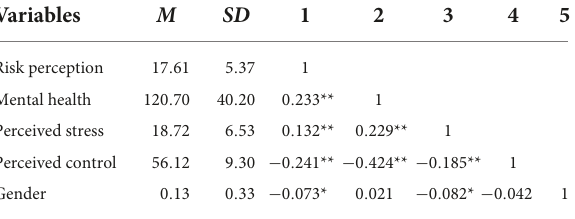
TABLE 1 Descriptive statistics and